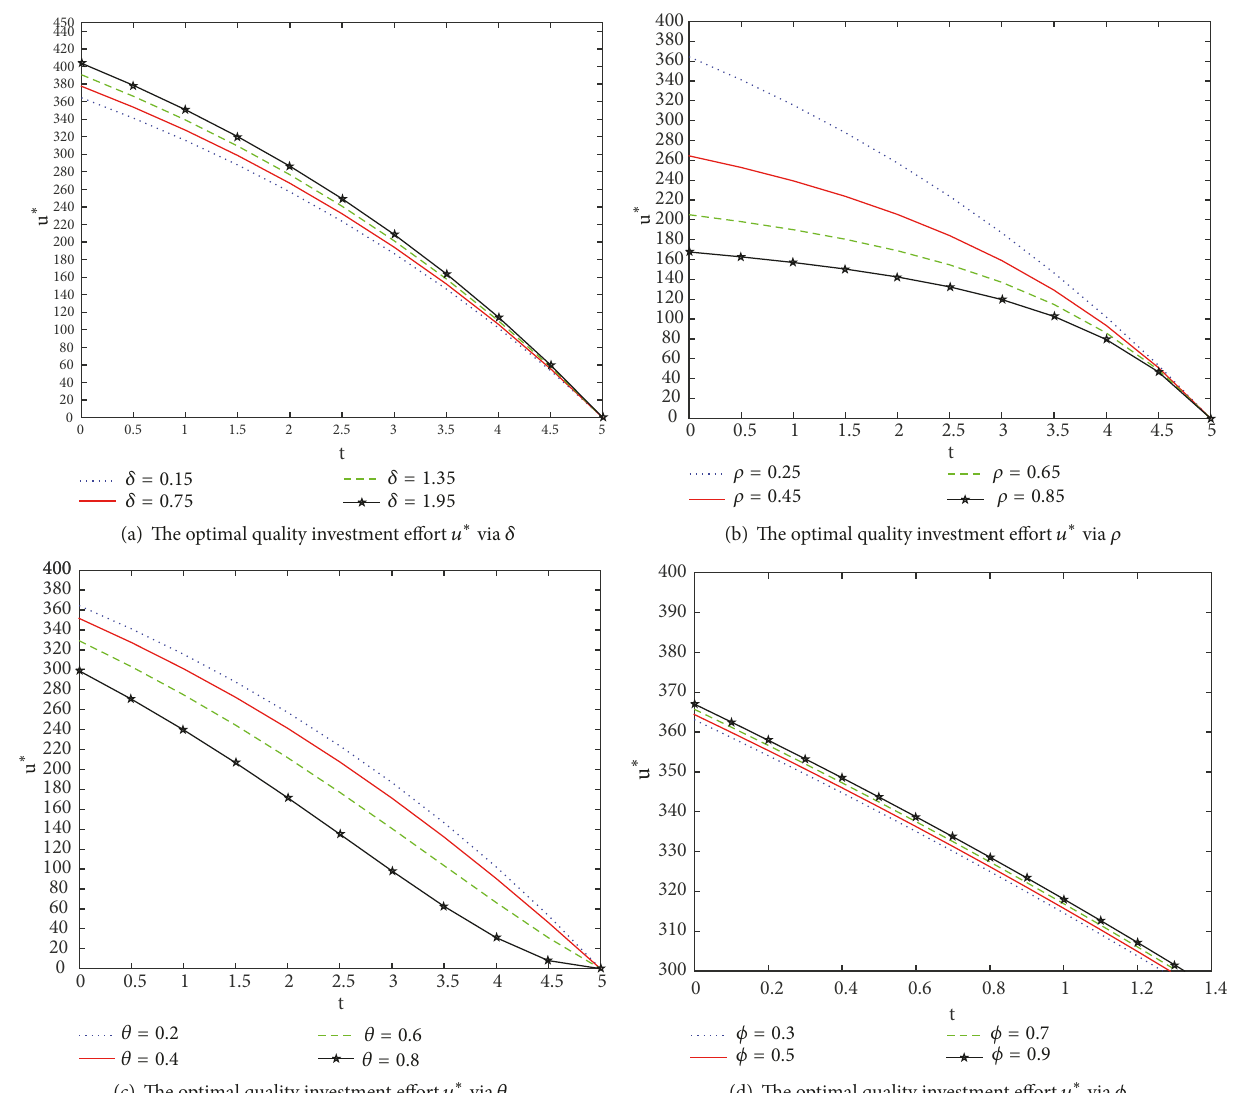
Figure 2: The impacts of parameters 𝛿, 𝜌,𝜃 , and 𝜙 on the optimal quality investment effort 𝑢 ∗ .